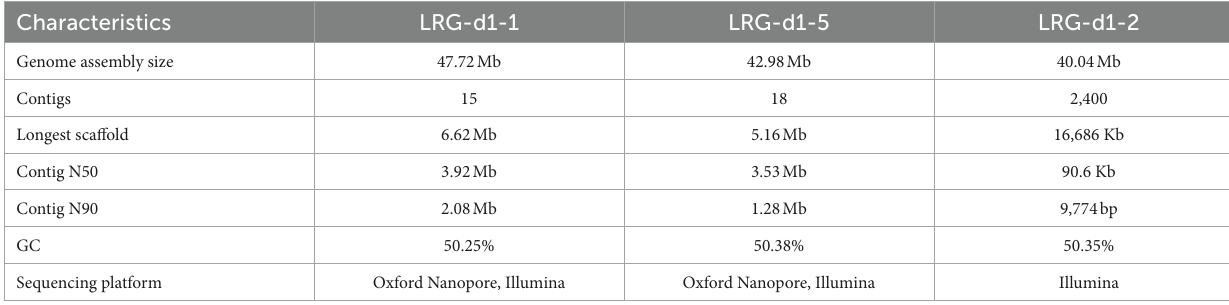
TABLE 1 De novo genome assembly and features of Lyophyllum decastes